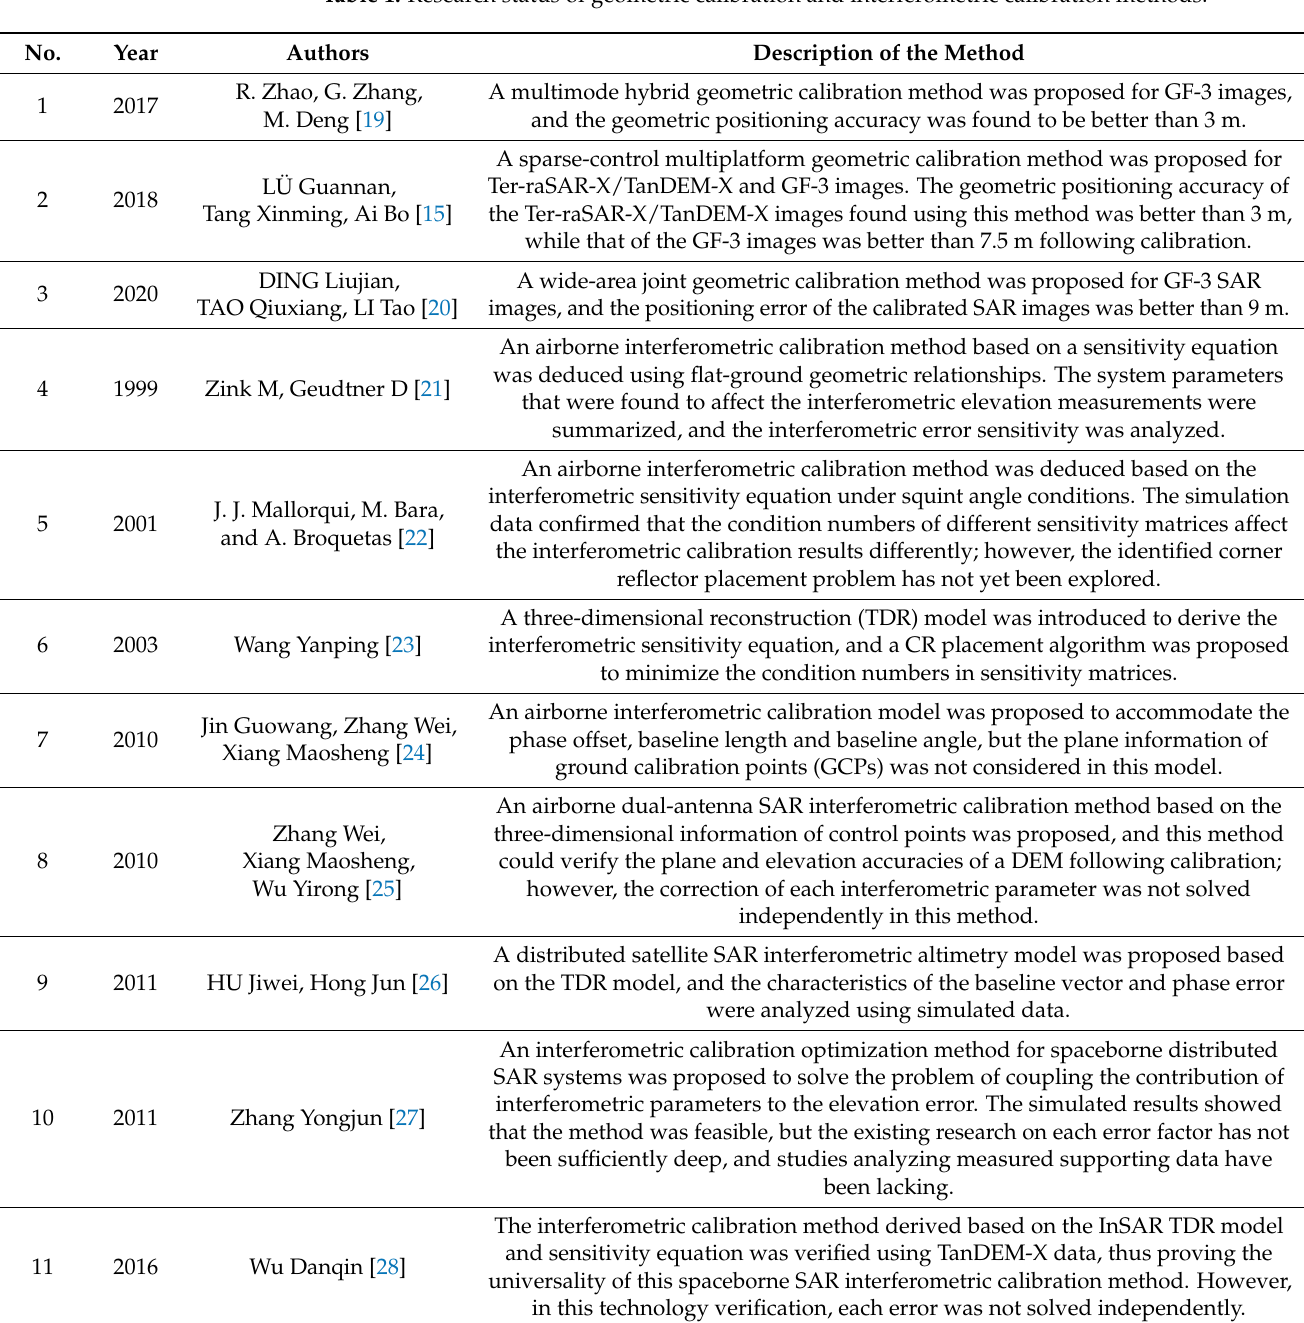
Table 1. Research status of geometric calibration and interferometric calibration